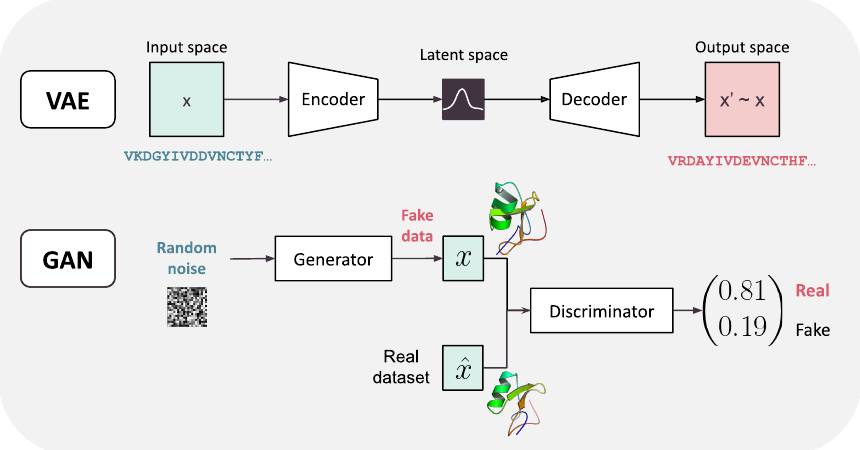
Figure 5. Examples of generative models. From top to bottom: Variational Autoencoder (VAE) and Generative Adversarial Network (GAN) models. The encoder, decoder, generator, and discriminator may be neural networks of any type (including MLPs, recurrent, and